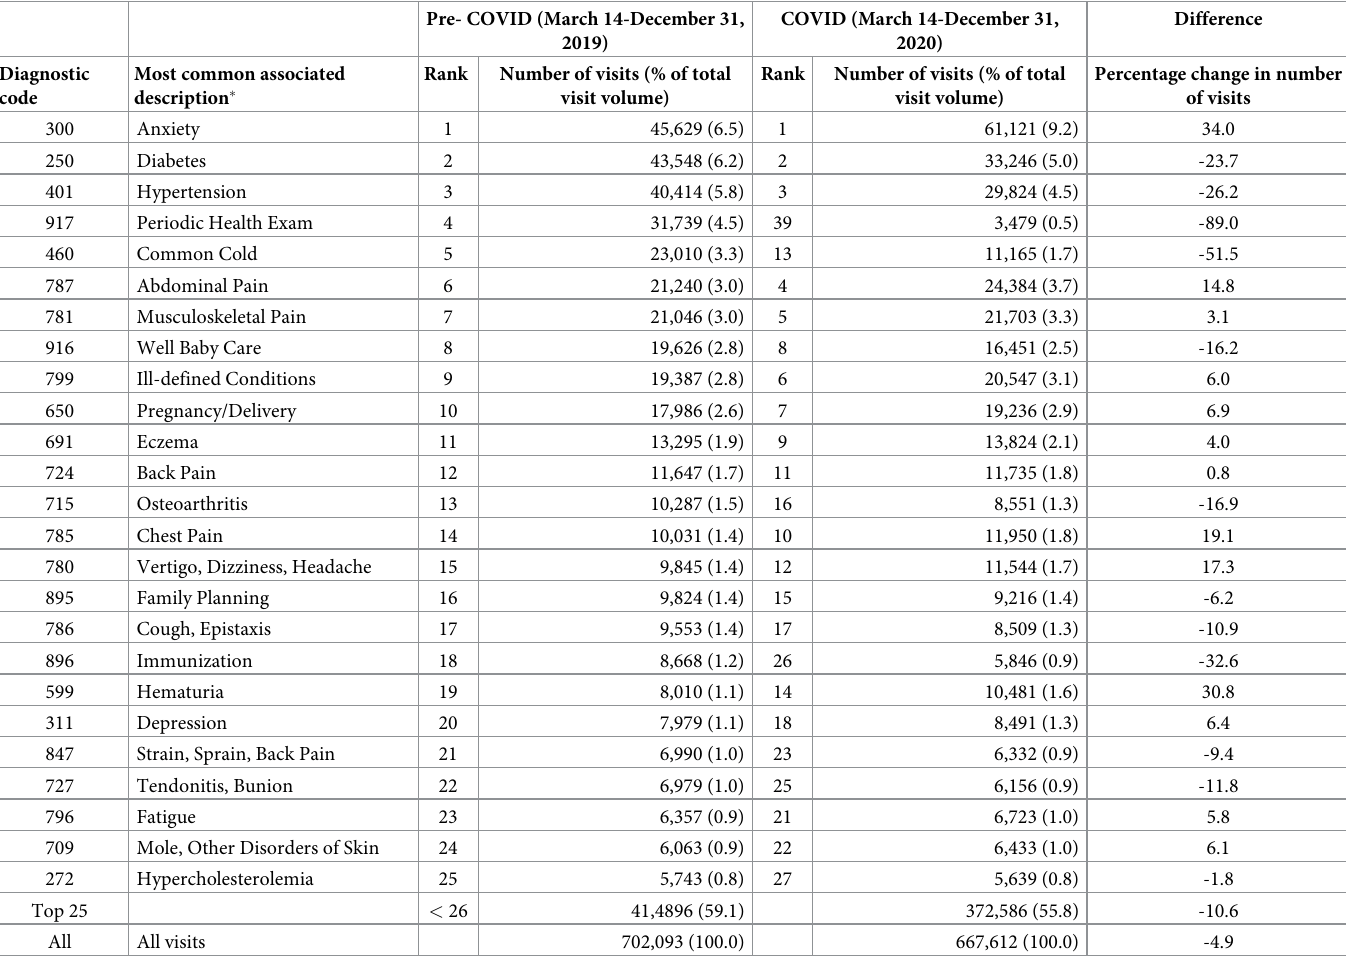
Table 2. Frequency of the most common diagnostic codes billed for primary care